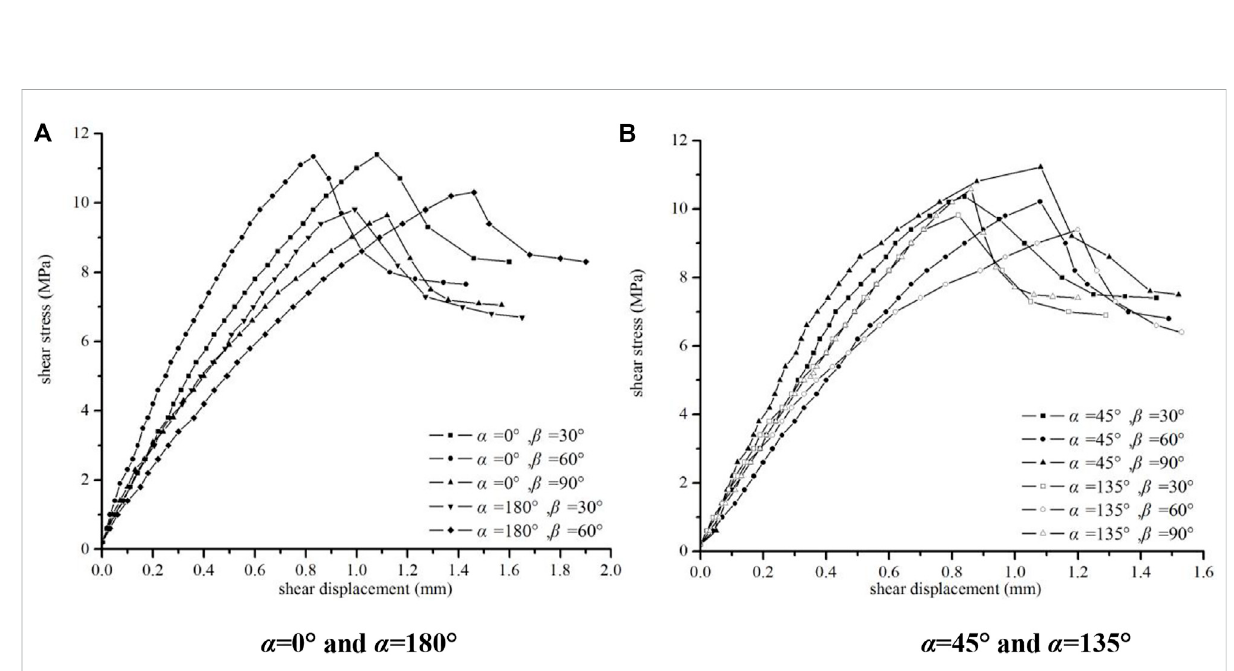
FIGURE 14 Shear stress-shear displacement curve (normal stress is 5 MPa). (A) α = 0 ° and α = 180 ° , (B) α = 45 ° and α = 135 °